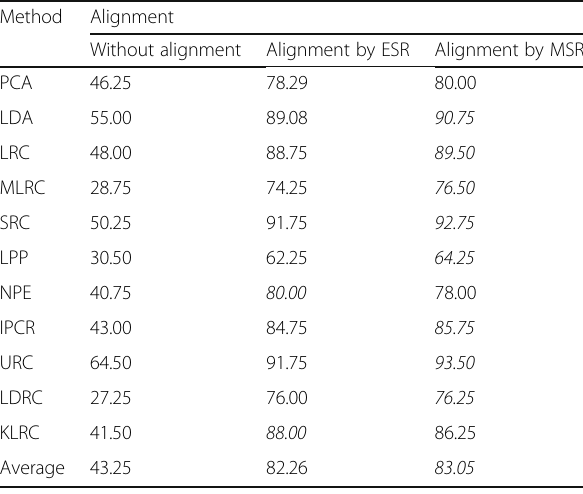
Table 8 Recognition performances (%) on FRGC database (Synthesized Faces) Method Alignment Without alignment Alignment by ESR